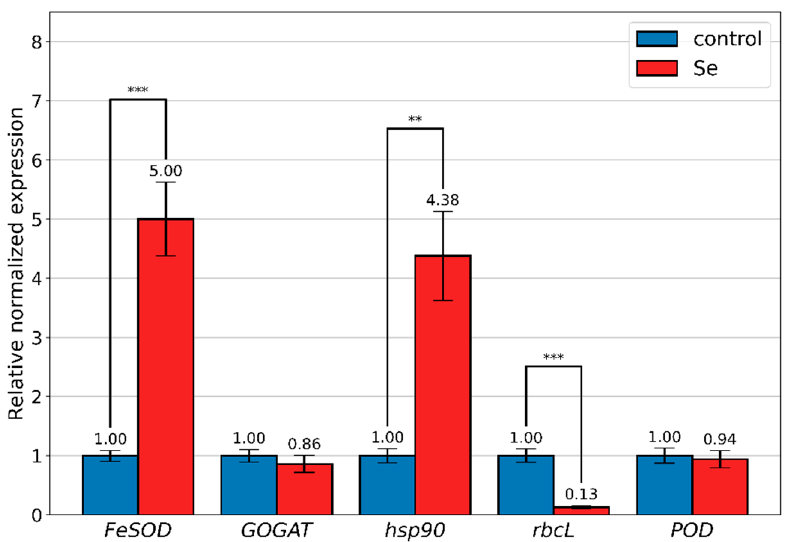
Figure 8. Relative expression difference in selected genes between control A. platensis and after Se treatment (200 mg/L of Na 2 SeO 3 ), ** p < 0.01, *** p < 0.001; n = 3. The error bars represent the standard deviation of the measurements.